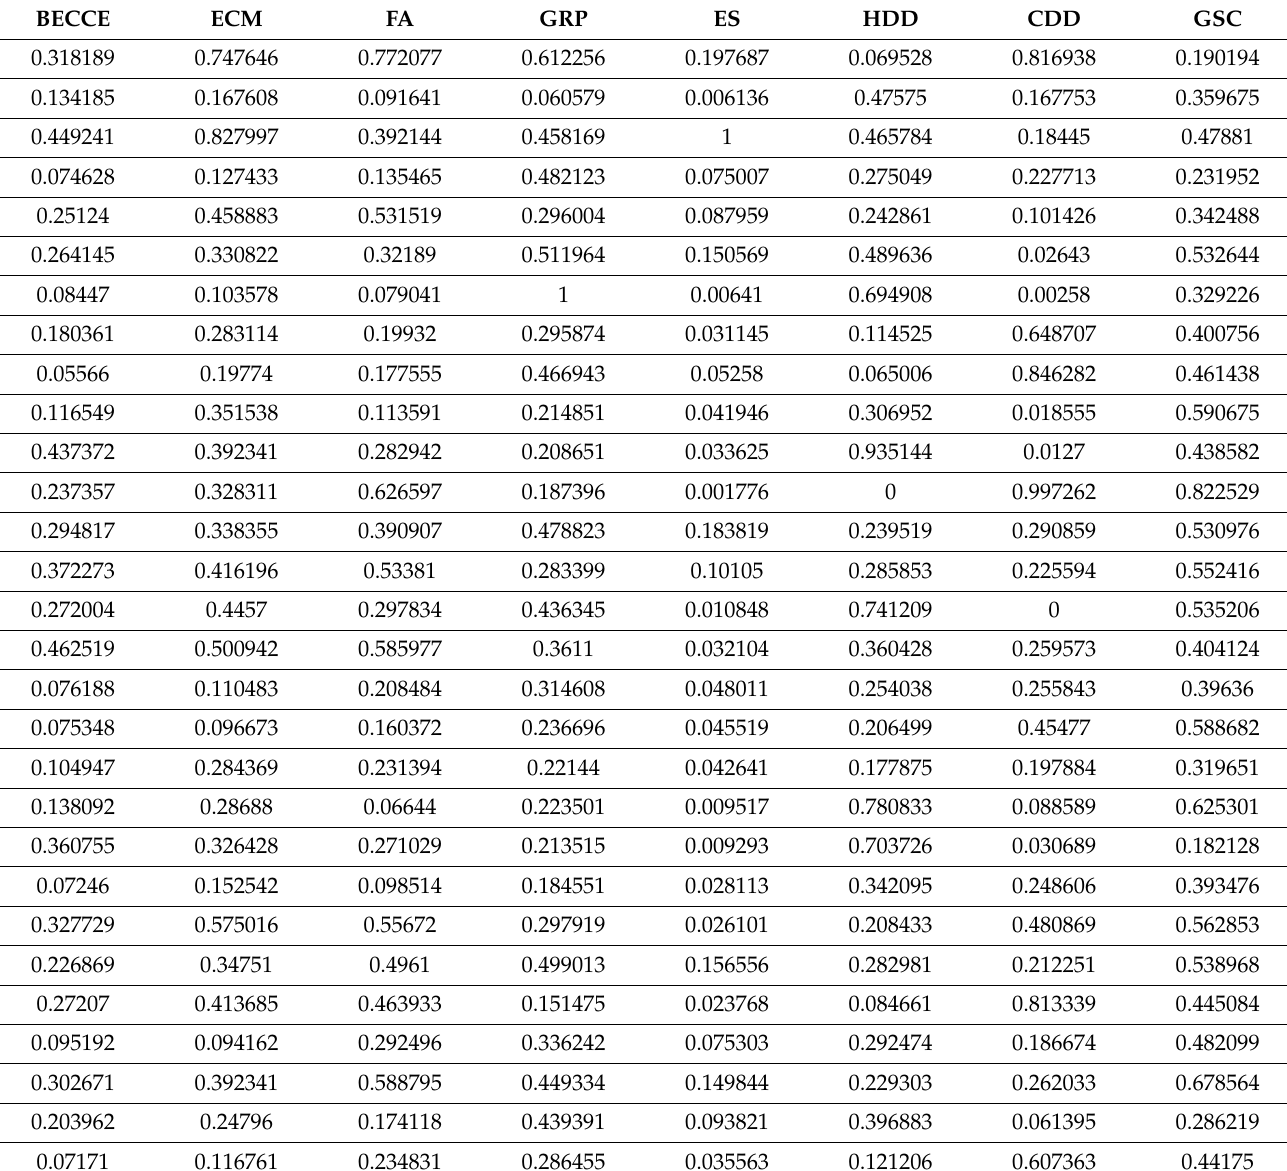
Table A1. Information with each variable after